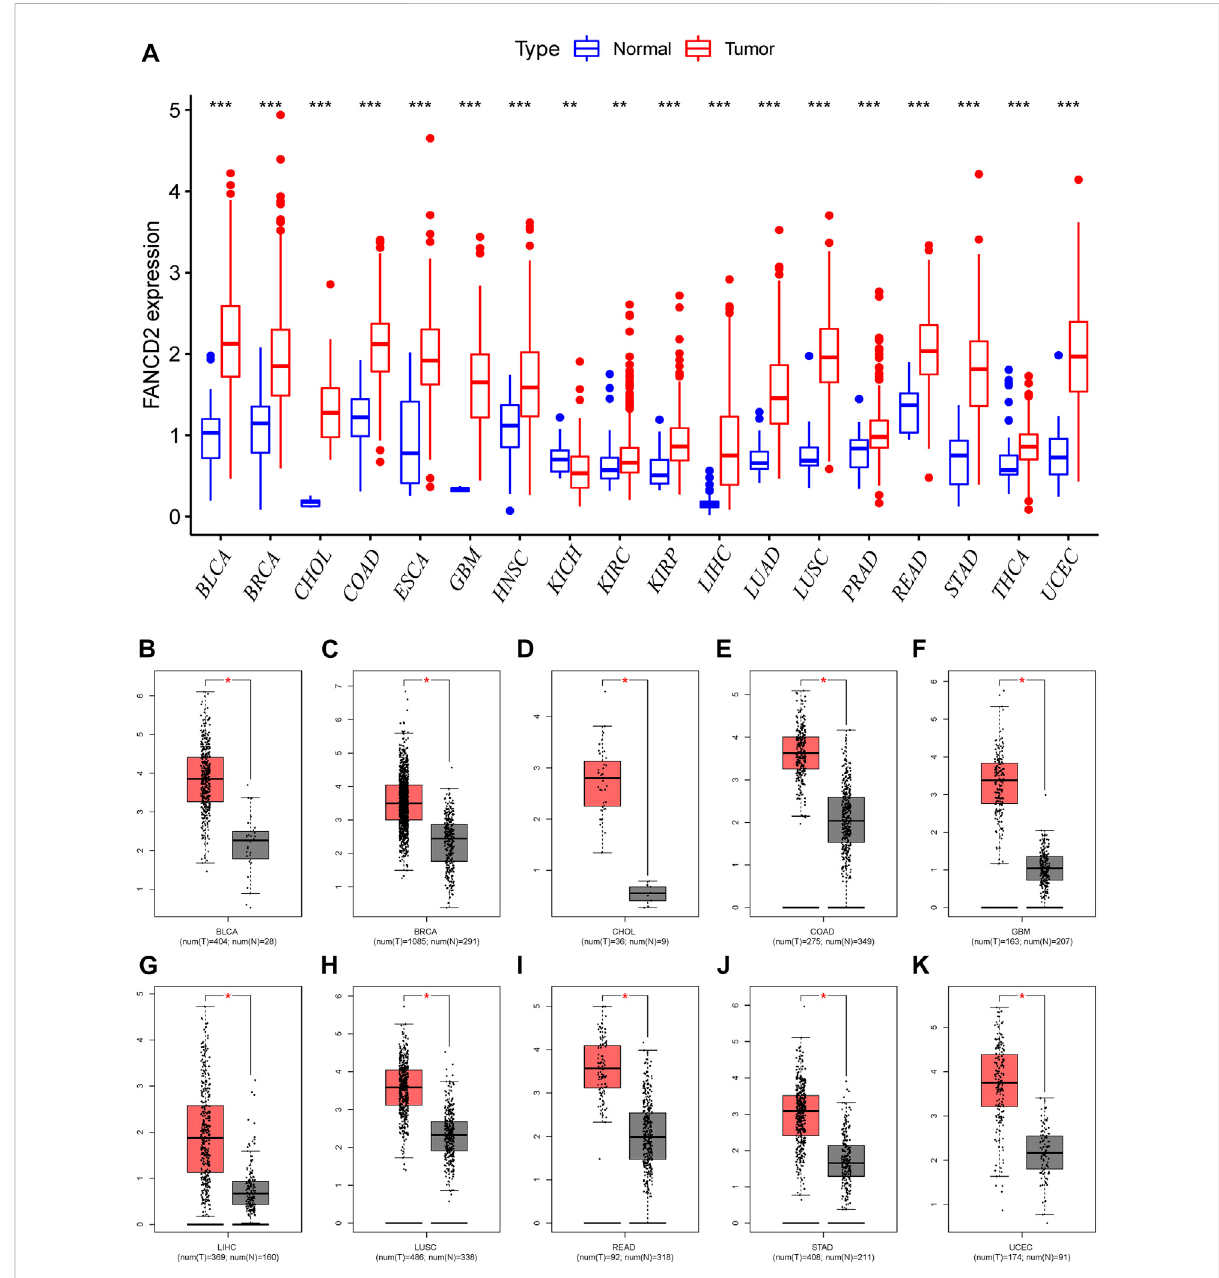
FIGURE 2 Pancancer expression pro fi ling analysis of FANCD2. (A) Interactive body map of FANCD2 mRNA expression constructed by GEPIA. (B – K) Expression of FANCD2 was analyzed between TCGA cancer tissues and GTEx normal tissues (* p < 0.05, ** p < 0.01, *** p <